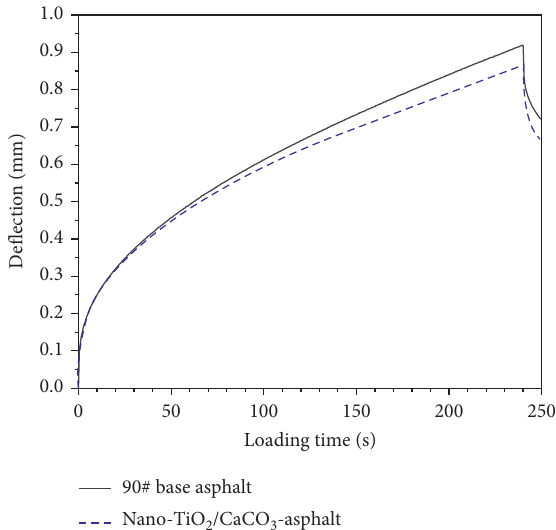
Figure 9: Creep curve of base bitumen and nano-TiO